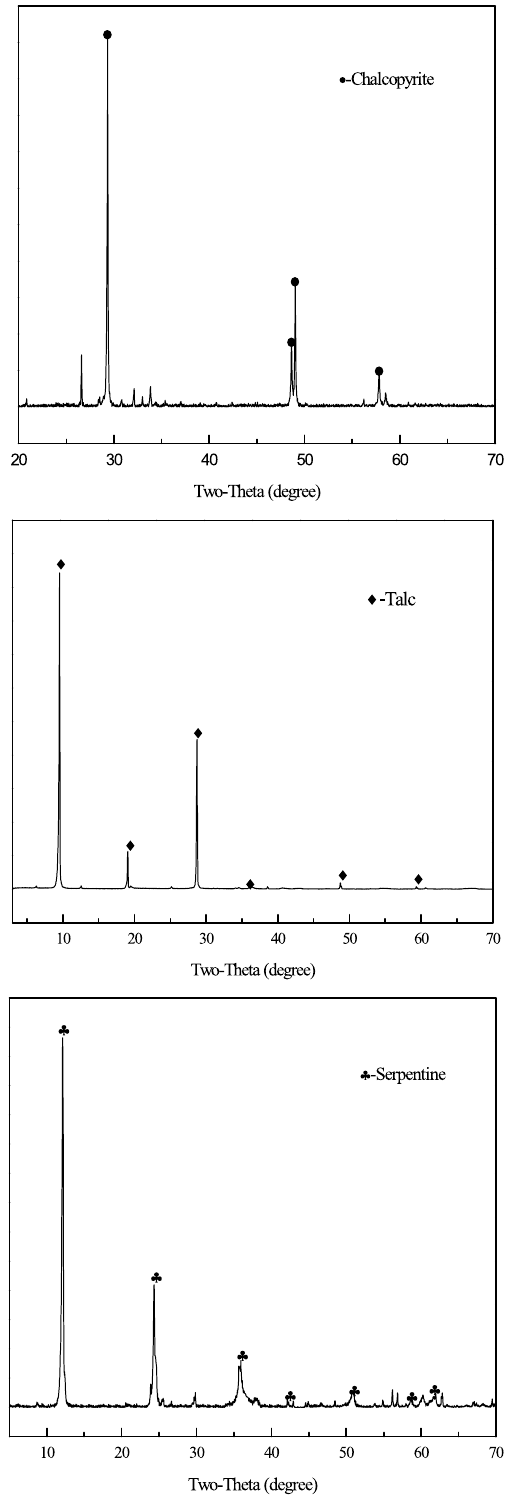
Figure 1. XRD patterns of the chalcopyrite, talc and